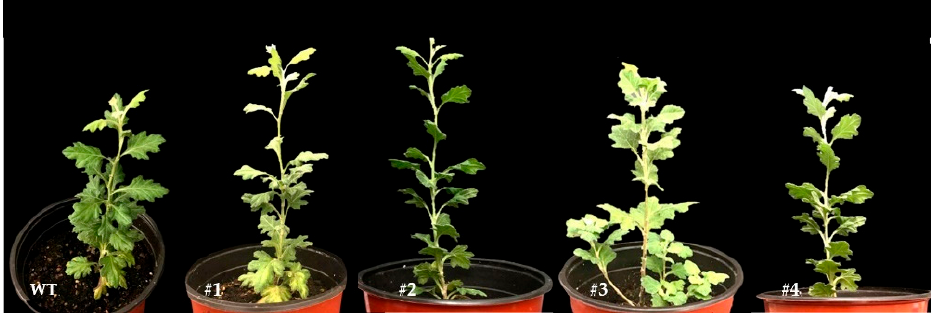
Figure 9. Phenotype of WT and CmTFL1a transgenic lines of Chrysanthemum. WT represents wild-type plant while #1-4 are positive CmTFL1a transgenic lines of Jinba.